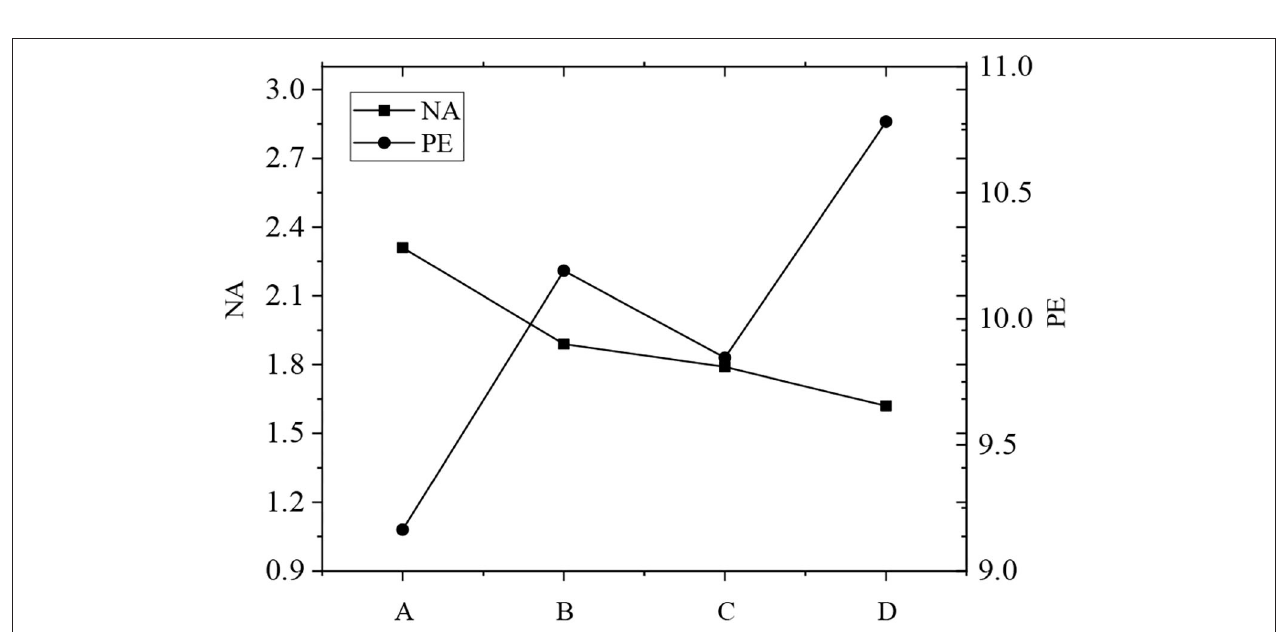
FIGURE 4 | Mean score of positive emotion of NA and